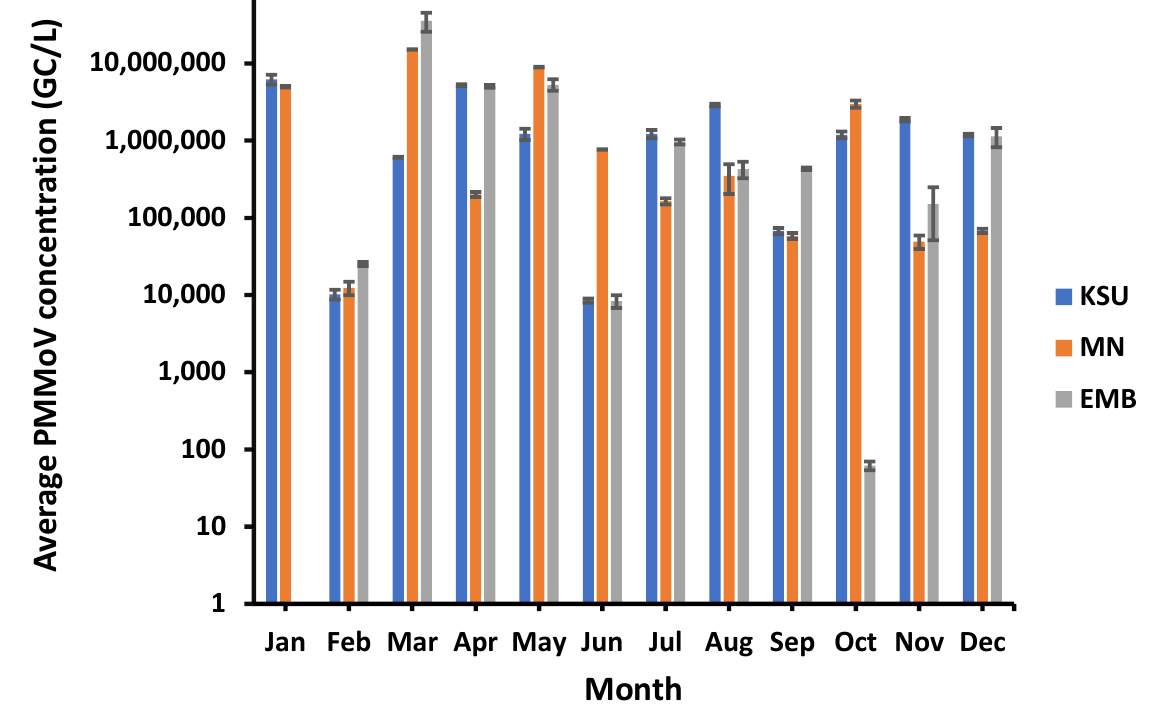
Figure 1. PMMoV concentration in raw water of the different WWTPs.